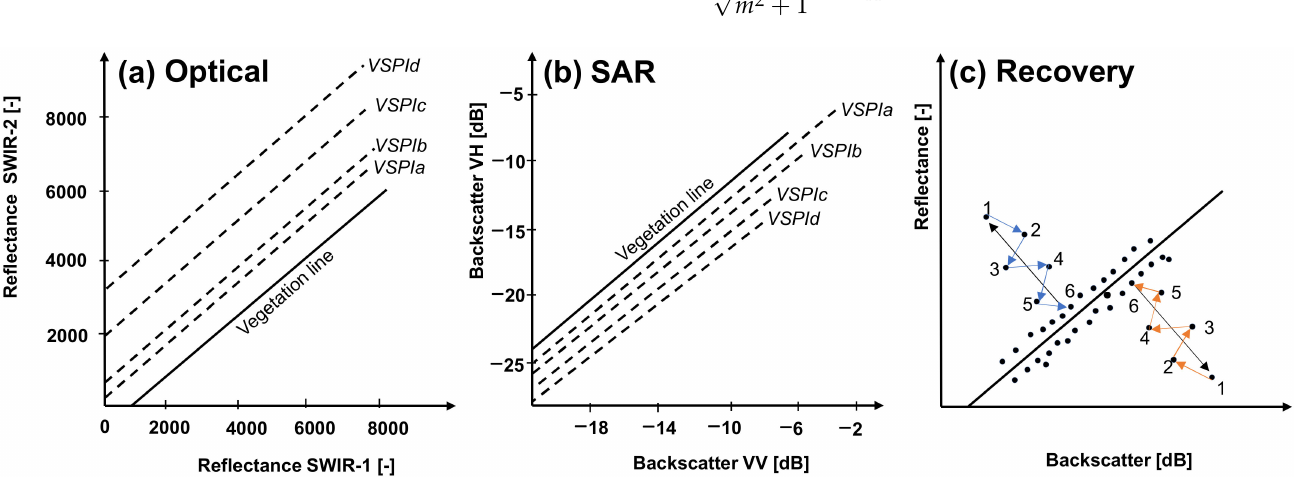
Figure 1. Illustration of VSPI on optical ( a ), SAR ( b ). The solid line represents the healthy vegetation, whereas the dashed isolines (VSPIa, VSPIb, VSPIc, VSPId) represents the orthogonally displaced vegetation point due to external disturbances, such as wildfires. The optical values of SWIR-1 and SWIR-2 bands are expressed as scaled surface reflectance in linear units, whereas the SAR values of VH and VV polarization channels are expressed in dB scale. ( c ) Schematic illustration of undisturbed vegetation (dots along the vegetation line) and the recovery of the disturbed vegetation to the pre-fire state; from point 1 to 6 for Optical (blue) and SAR (Orange) data. Illustrations in Figure 1a,c are adapted from